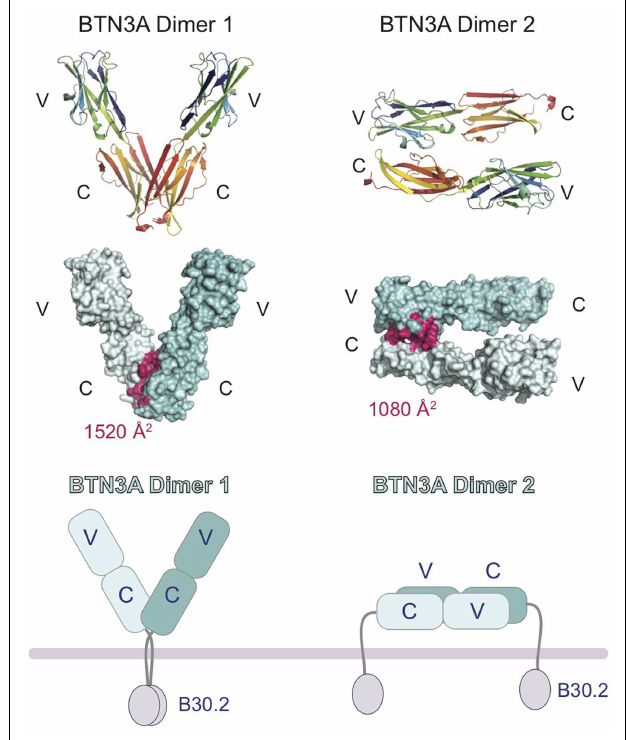
FIGURE 3 | Cartoon representation of the domain organization of the butryophilin-3 (BTN3) proteins . Structures of the extracellular domains of the BTN3A1 proteins shown in the two dimeric states present in the crystal lattice. Dimer 1 (left) associates via the IgC domains and forms aV-shaped dimer, placing the intracellular B30.2 domains in close proximity to each other. Dimer 2 (right) associates in an head-to-tail fashion with the IgV domain of one BTN3A monomer interacting with the IgC domain of another.This would result in the dimer laying parallel to the cell-surface, with the intracellular B30.2 domains separated.The interface contact residues are colored pink and shown on the surface representation of the two dimeric forms (middle panel).The buried surface area (BSA) is shown for both